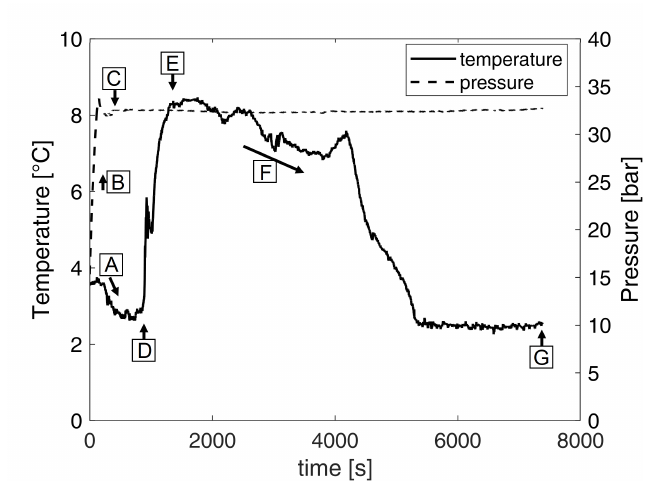
Figure 2. Temperature and pressure curves are exemplarily shown for hydrate formation in the water-sucrose model solution at 32.5 bar and 3 °C: the system is cooled to the desired temperature ( A ). Subsequently, pressure is build up ( B ) and set to the desired value ( C ). The start of hydrate formation is indicated by a rising temperature ( D to E ). This temperature rise is followed by another cooling step ( F ). The experiments were stopped two hours after the start of hydrate formation ( G ). After the hydrate had formed, it was removed from the reactor as a solid